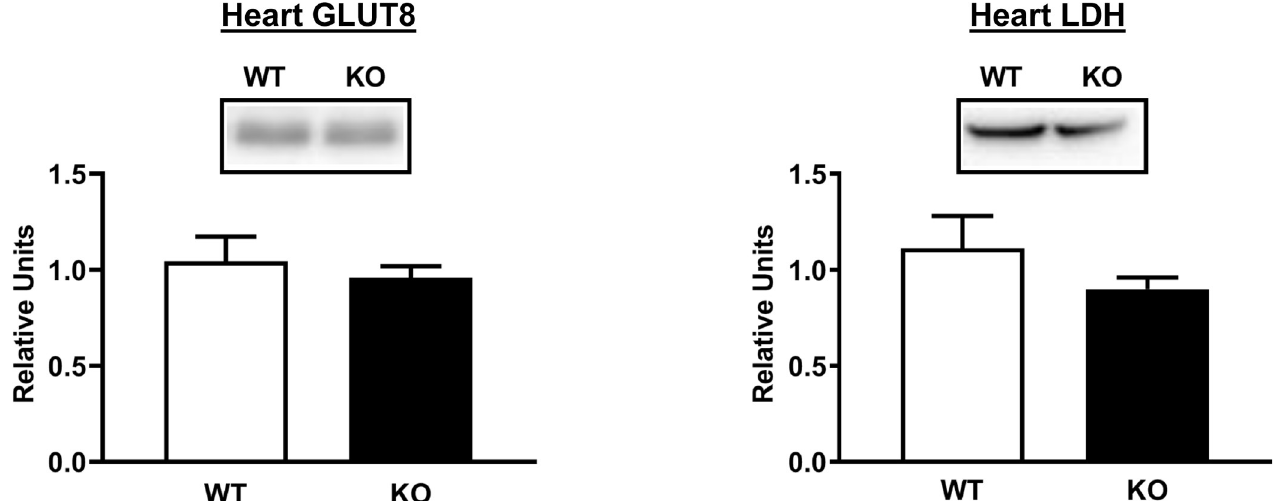
Fig 9. GLUT8 and LDH abundance in tissues from WT (white bars) and KO (black bars) animals subjected to the HEC. Means ± SEM for 4 rats of each genotype.